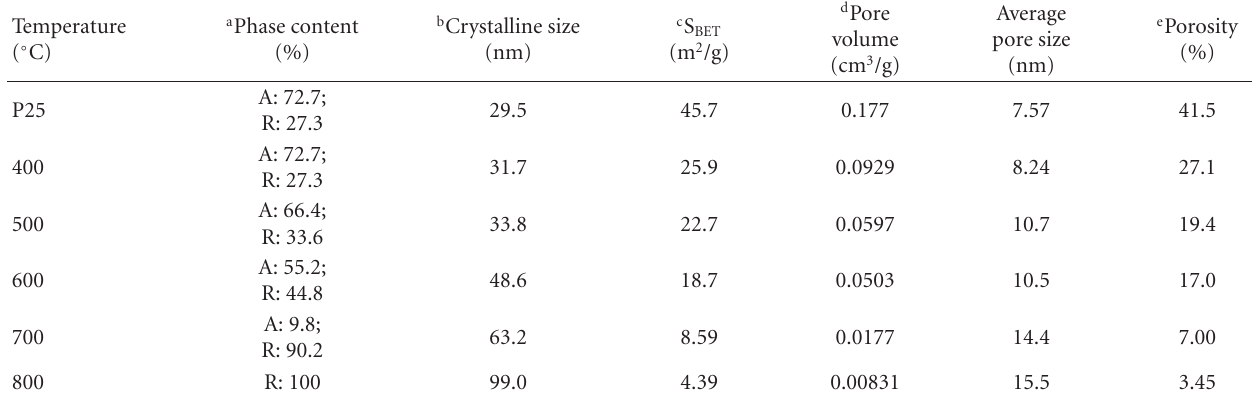
Table 1: E ff ect of temperature on physicochemical properties of TiO 2 samples.